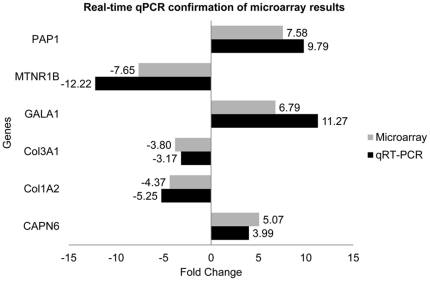
Relative mRNA levels.Indicated by fold change versus controls, the expression levels of the selected genes analyzed by microarray (grey bar) and quantitative RT-PCR (black bar) in the scrapie medulla oblongata are shown.